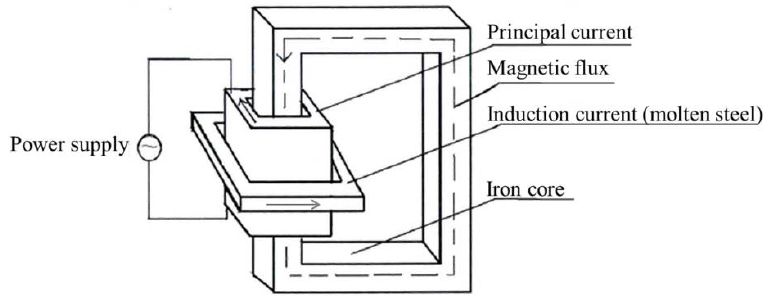
Figure 1. Schematics of the channel type induction heating (CTIH) principle of the